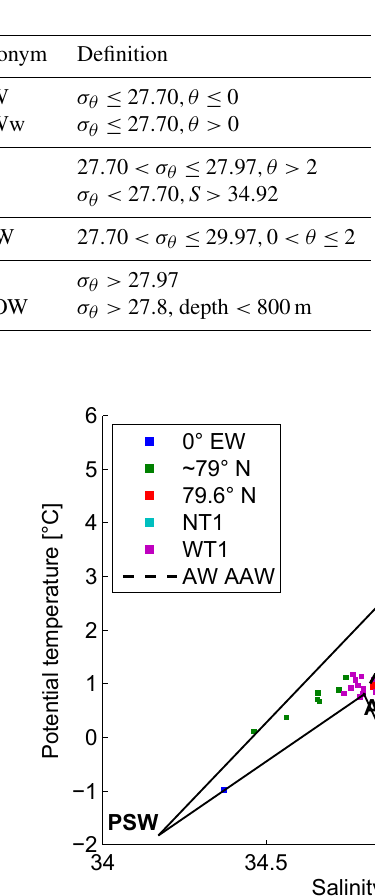
Table 1. Water mass definitions after Rudels et al. (2005). Boundaries of potential temperature θ in ◦ C and potential density σ θ in kgm − 3 are given; σ θ is potential density referenced to the sea surface.